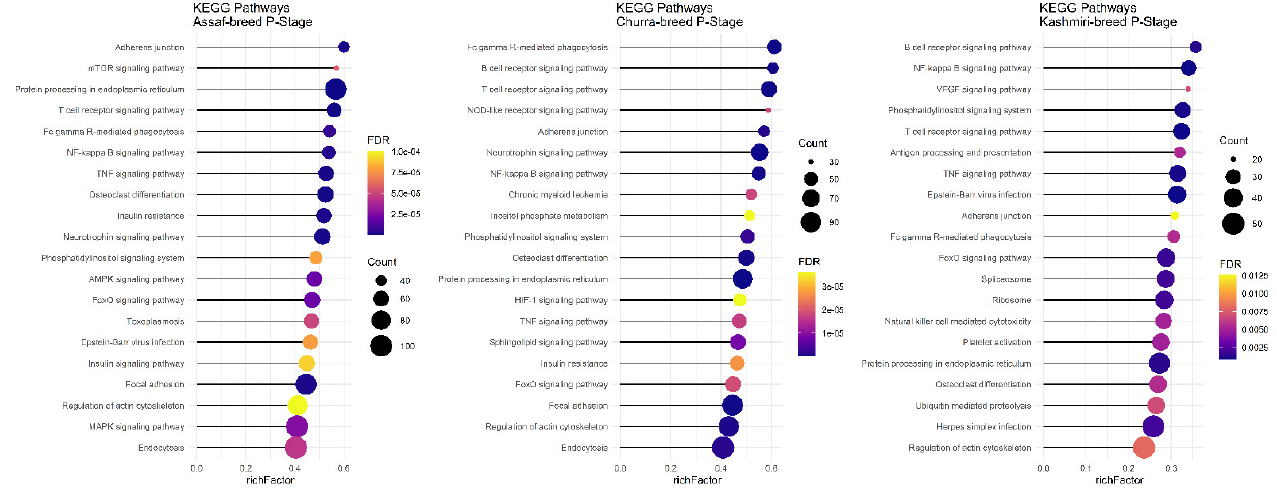
Figure 8. Functional enrichment analysis results of P stage in Assaf, Churra, and Kashmiri breeds. Since the significant KEGG pathways term is large, only 20 top significant terms are shown. The color and size of points indicate FDR and the number of genes associated with each term, respectively.